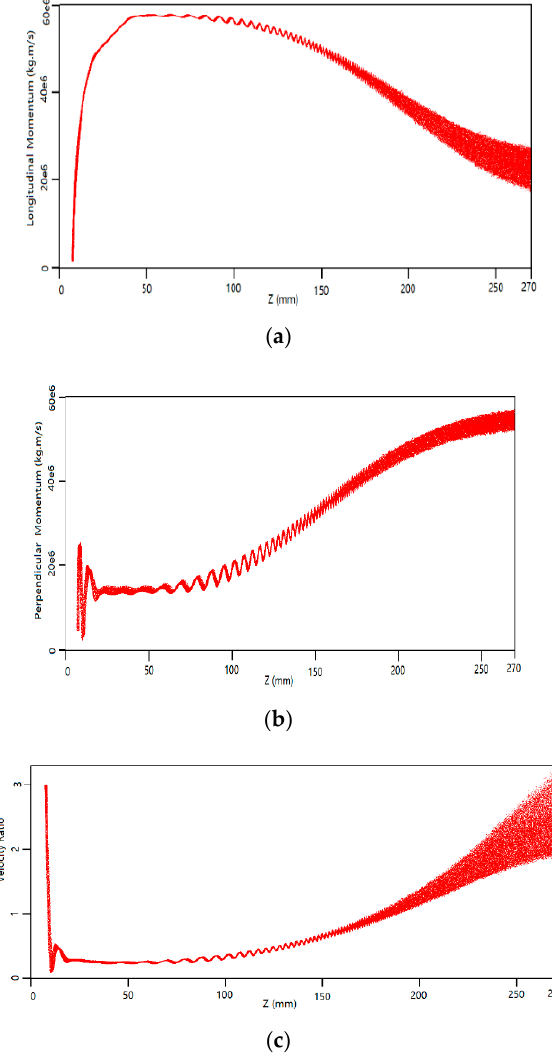
Figure 5. Optimized geometry, magnetic field profile and beam trajectory of MIG by Magic code.